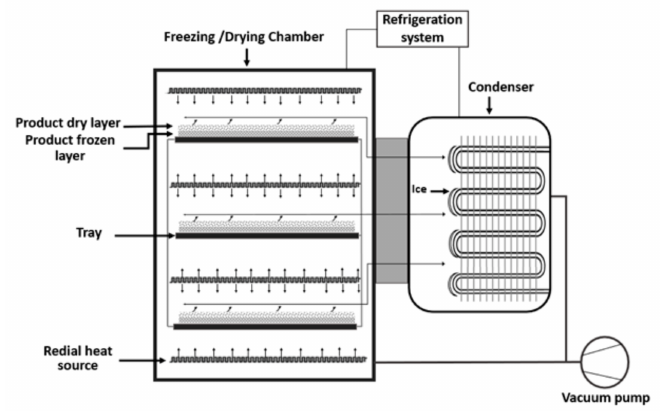
Figure 4. Schematic diagram of the freeze-drying process (self-developed, the concept was adopted from [39,46]). Reproduced with permission from [46]. Copyright Elsevier,